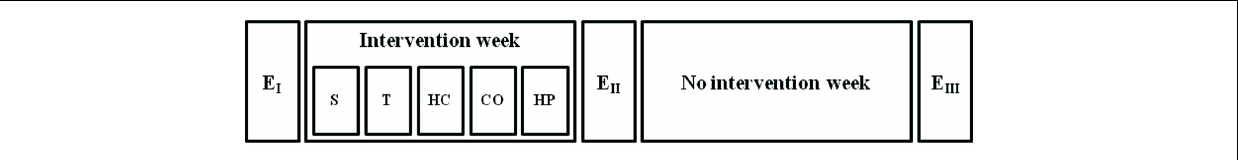
FIGURE 1 | Protocol for evaluation of hybrid gait training with Kinesis overground robot in iSCI. Examination sessions and walking conditions are identified as follows.Walking function evaluation session: E; examination of response to EMS: S; training session:T; hybrid-cooperative condition: HC; cooperative-only condition: CO; hybrid-stiff condition: